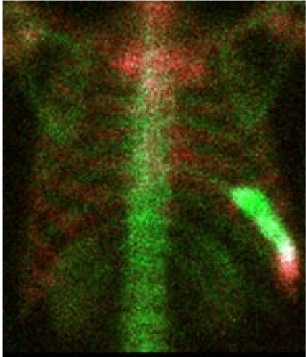
Figure 9. Three-dimensional formation of the anterior and posterior views of a bone scan (the spatial relation is used in the proposed